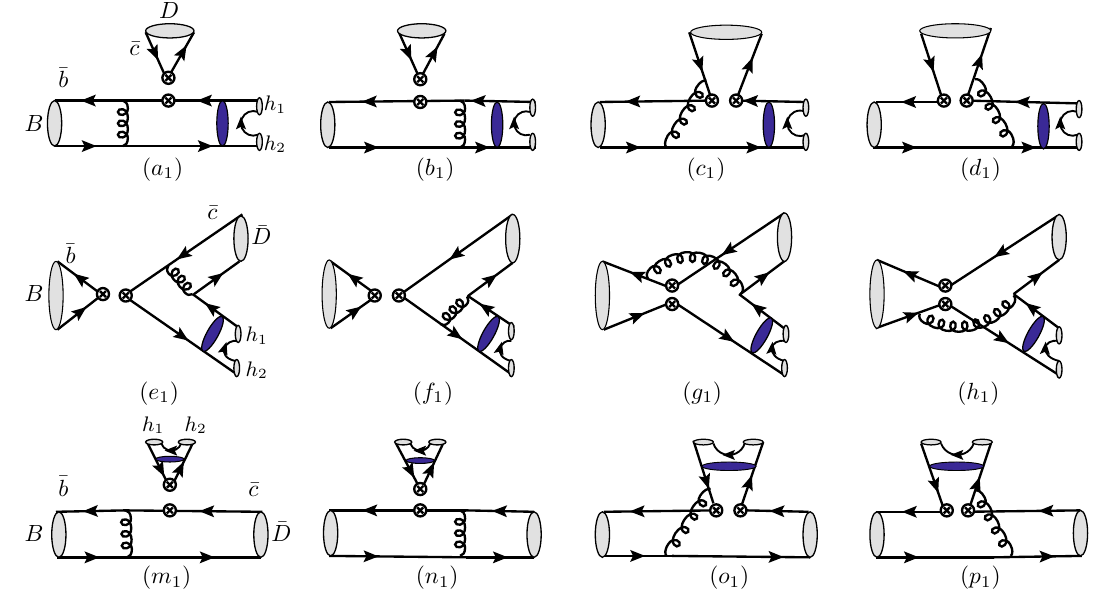
Fig. 1 The leading-order Feynman diagrams for the quasi-two-body theory [88]. When considering the color structure of the diagrams for thesingle-gluonexchangebetweentwocolor-singletweak-currents,the decays B ( s ) → ¯ D ( s ) K ∗ → ¯ D ( s ) K π where B ( s ) = ( B 0 , B + , B 0 s ) and ¯ D ¯ D 0 , D − , D − π pair and the blue ( s ) =( s ). The h 1 h 2 denotes the K ellipse represents the intermediate state K ∗ . The “ ⊗⊗ ” in the diagrams represents the insertion of the 4-fermion operator O i in the effective